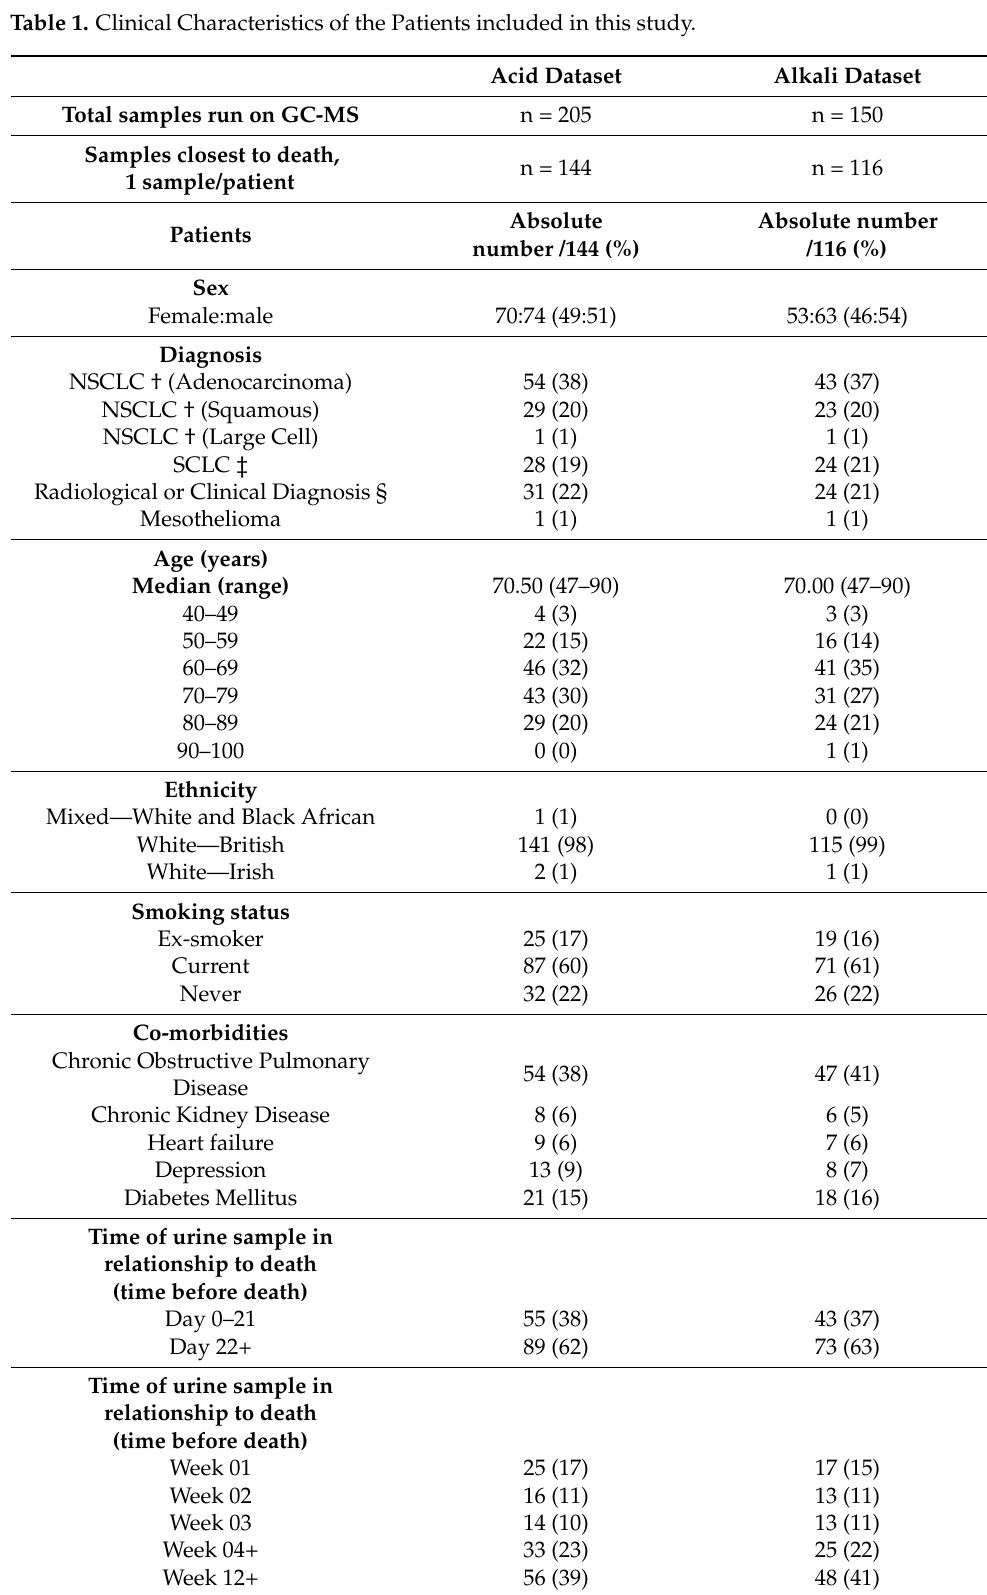
Table 1. Clinical Characteristics of the Patients included in this